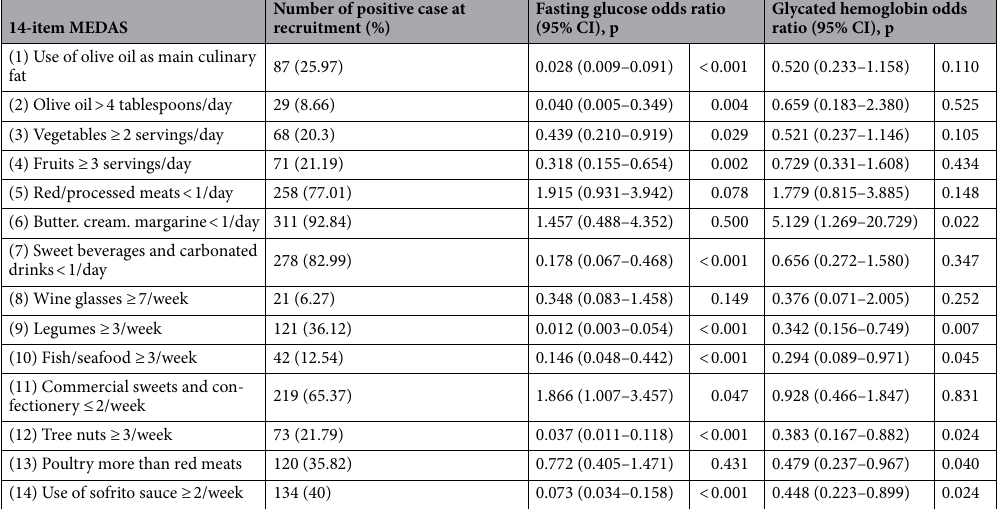
Table 3. Multivariable-adjusted odds ratios (95% confidence intervals) from logistic regression for abnormal blood glucose level according to the fulfillment of each item in the MEDAS. Adjusted for gender, age, BMI. MEDAS Mediterranean diet adherence screener, CI confidence